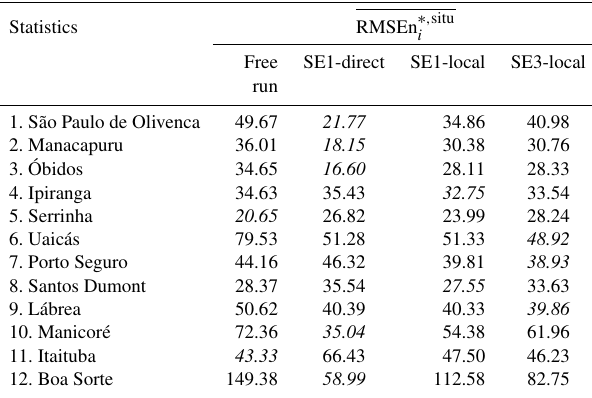
Table 7. Statistics between analysis and in situ stations for the dif- ferent assimilation experiments. Italic values indicate the best result among the three experiments for all tested